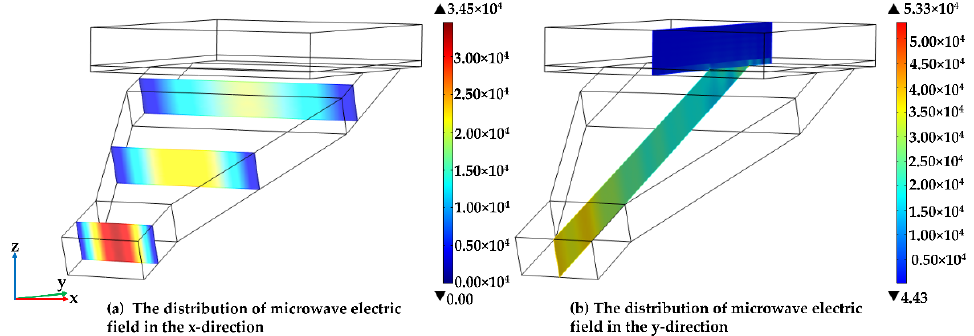
Figure 3. Distributions of the microwave electric field in the reactor at different planes (Unit: V/m).